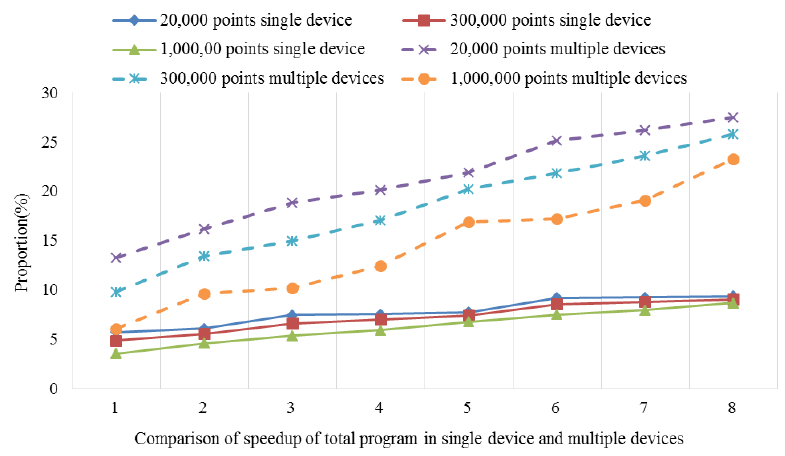
Figure 12. Comparison of the speedup obtained using single/multiple cards on Intel Xeon Phi ( Speedup A ).